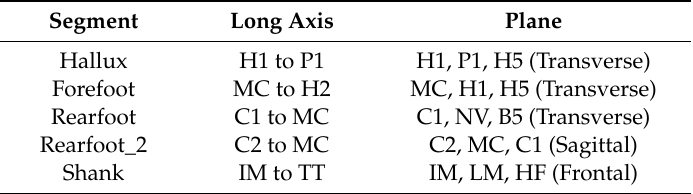
Table 2. Segment reference frames defined by a primary axis, a